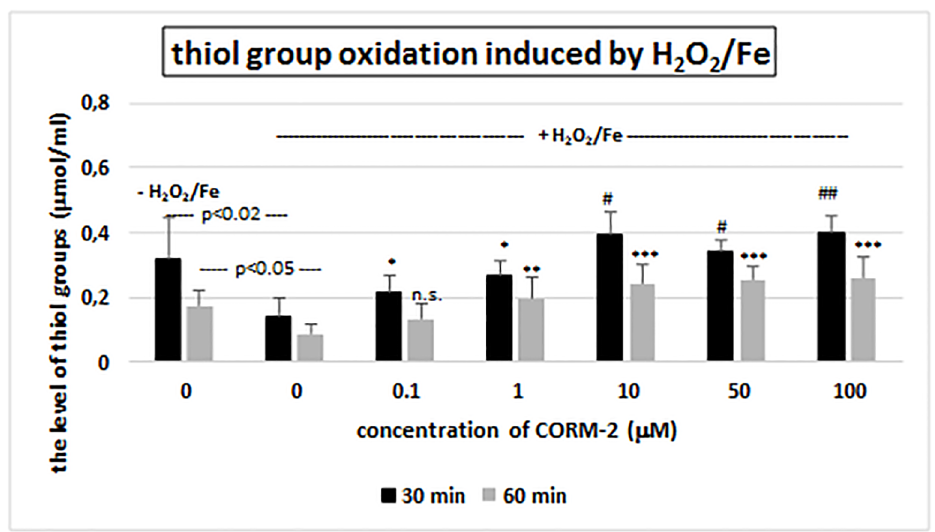
Fig 5. The effect of CORM-2 (0.1–100 μ M, incubation time– 30 and 60 min) on the oxidation of protein thiols induced by H 2 O 2 /Fe. Data represents means ± SD of 6 experiments (from different donors). * p < 0.05 vs . control (+ H 2 O 2 /Fe), ** p < 0.01 vs . control (+ H 2 O 2 /Fe), *** p < 0.0002 vs . control (+ H 2 O 2 /Fe), # p < 0.0005 vs . control (+ H 2 O 2 /Fe), ## p < 0.00002 vs . control (+ H 2 O 2 /Fe), n.s. p > 0.05 vs . control (+ H 2 O 2 /Fe).